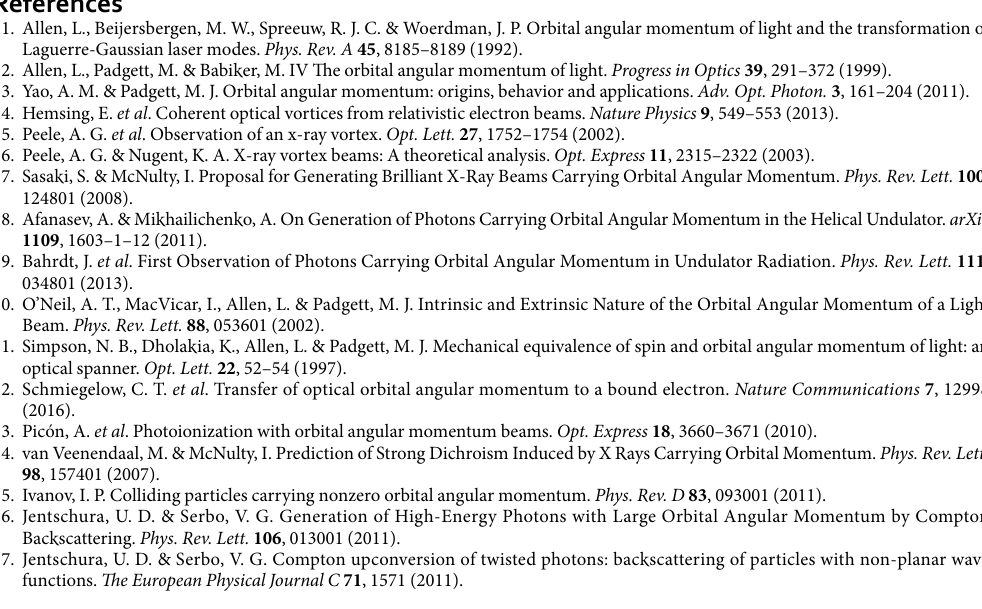
Gamma-ray vortices for the study of nuclear physics. Photons with non-zero OAM and energies larger than 1 MeV will open a new frontier in nuclear physics and nuclear astrophysics. The interaction between atomic nuclei and photons with energies of 1 < E < 30 MeV are dominated by nuclear resonances fluorescence and photo nuclear reactions. These reactions can be understood by a two-step model. First, an incident photon is absorbed by a nucleus and thereby the nucleus is exited. If the excitation energy is lower than particle separa- tion threshold, the excited nucleus subsequently decays out through nuclear resonances fluorescence with the emission of a gamma-ray or a cascade of gamma-rays. If the excited energy is higher than the particle threshold, the nucleus can decay out to a residual nucleus with the emission of a particle such as neutron or proton (photo nuclear reaction). The spin and parity of the excited nucleus populated by the absorption of a photon is limited by the conservation laws of angular momentum 31 , namely, | I i − I p | ≤ I f ≤ | I i + I p |, where I i and I f are the spin of the initial state and the exited state in the nucleus, respectively, and I p is the total angular momentum of the incident